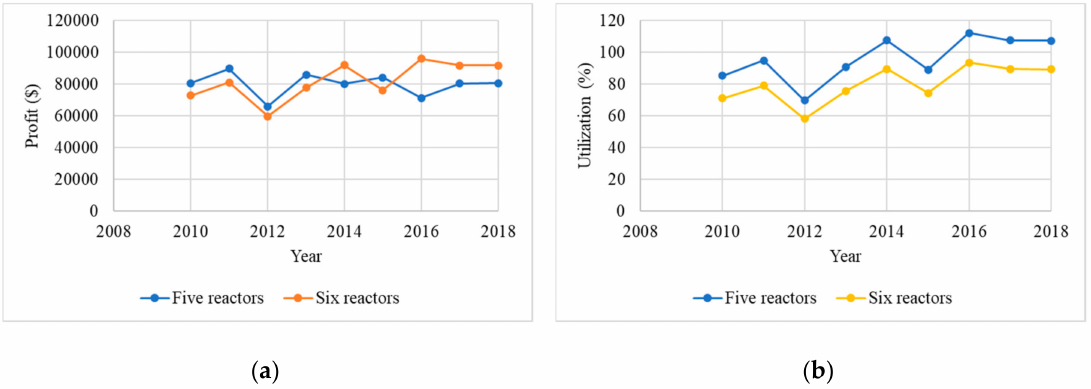
Figure 5. ( a ) Profit of two scenarios; ( b ) utilization of two